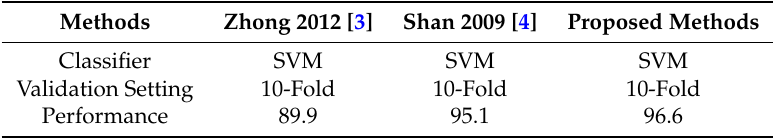
Table 5. Recognition rate on CK+ under LBP feature in different